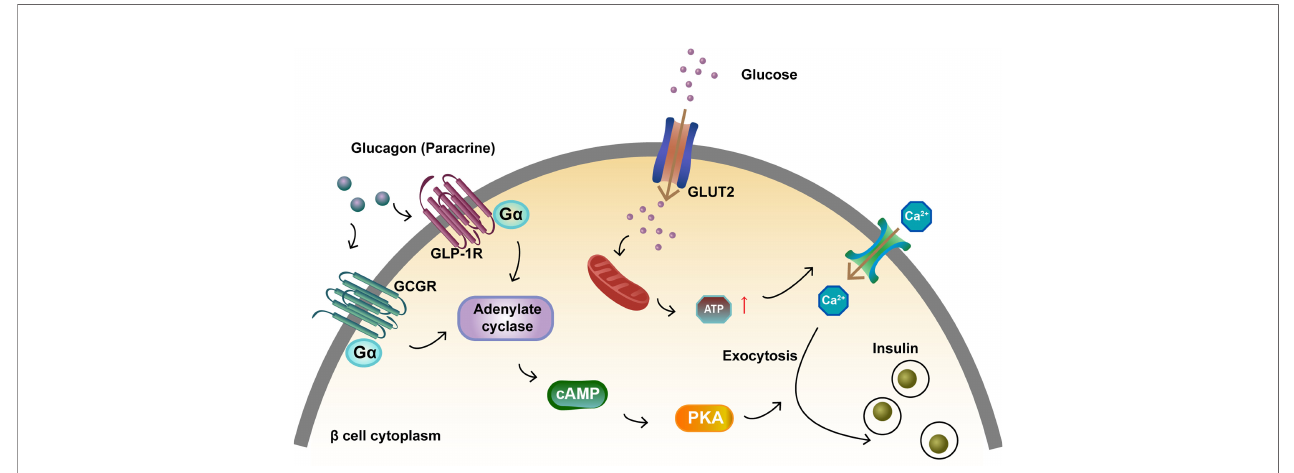
FIGURE 2 | Activation of GCGR and GLP-1R to promote insulin secretion in islet b cells. Glucagon binds to GCGR and GLP-1R on b cells and the activated receptors engage the G protein G a s. This results in adenylate cyclase activation and cAMP formation. Glucose binds to GLUT2, which increases ATP levels and intracellular calcium concentration, and enhances insulin exocytosis. The increase in intracellular cAMP levels activates PKA, which also promotes insulin